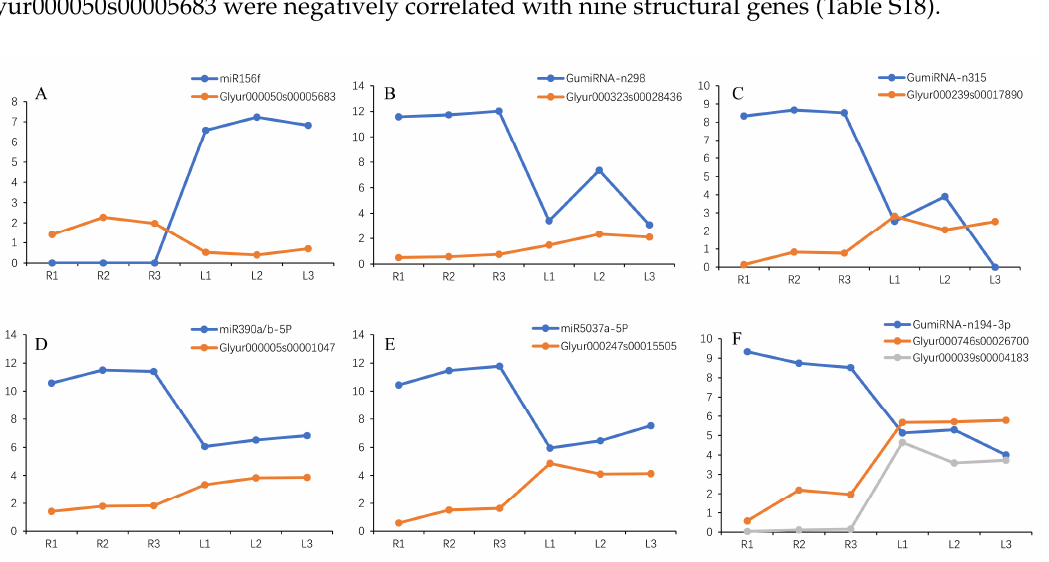
Figure 7. Expression patterns of six miRNAs and target genes. L, R stand for leaves and roots, respectively. Every tissue has three biological replicates.